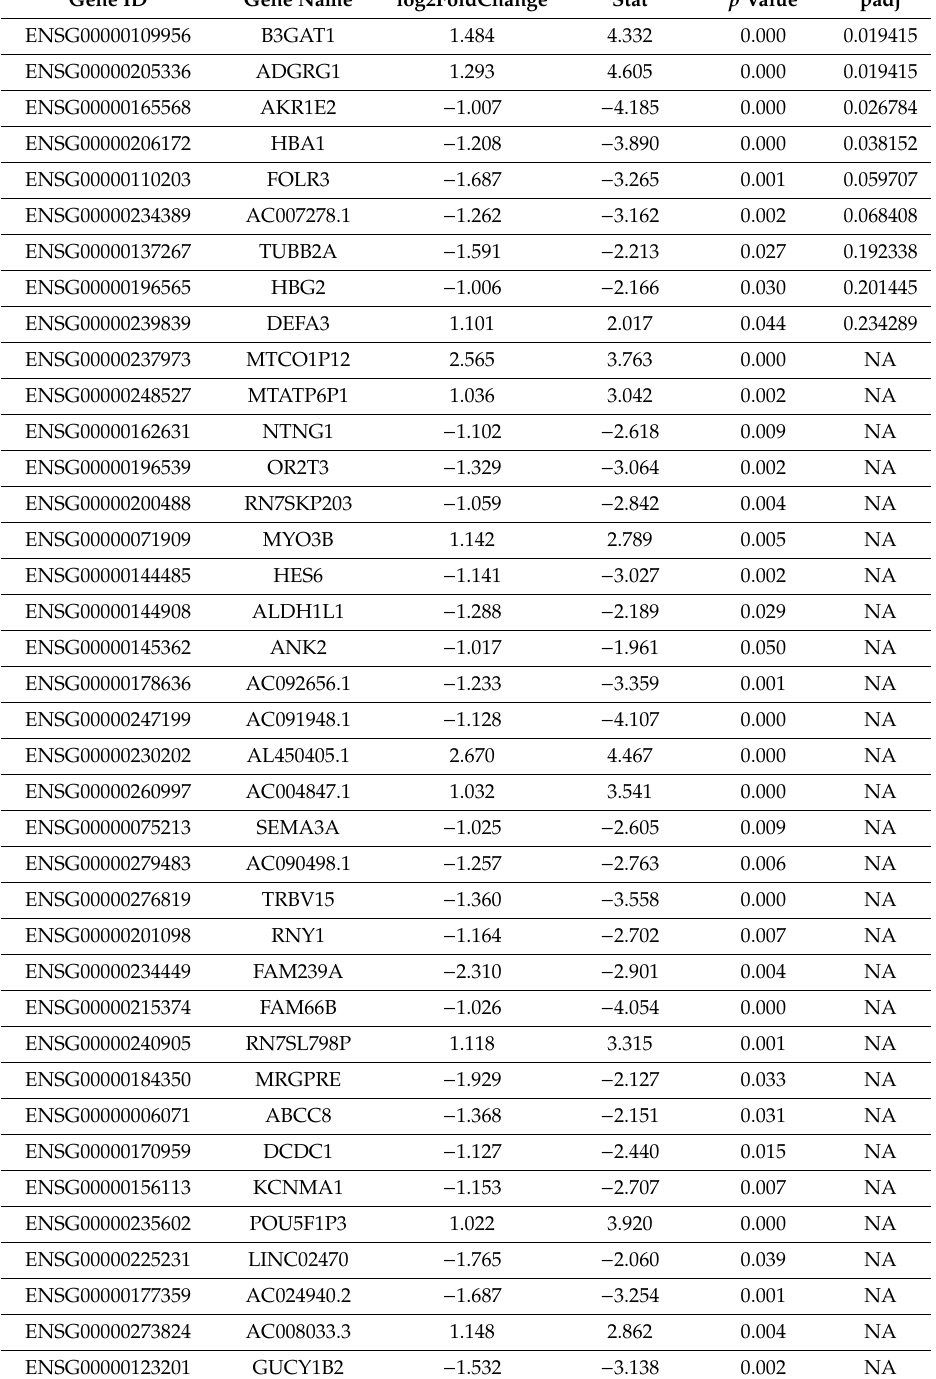
Table 2. Di ff erent expressed genes between HD gene carrier and healthy